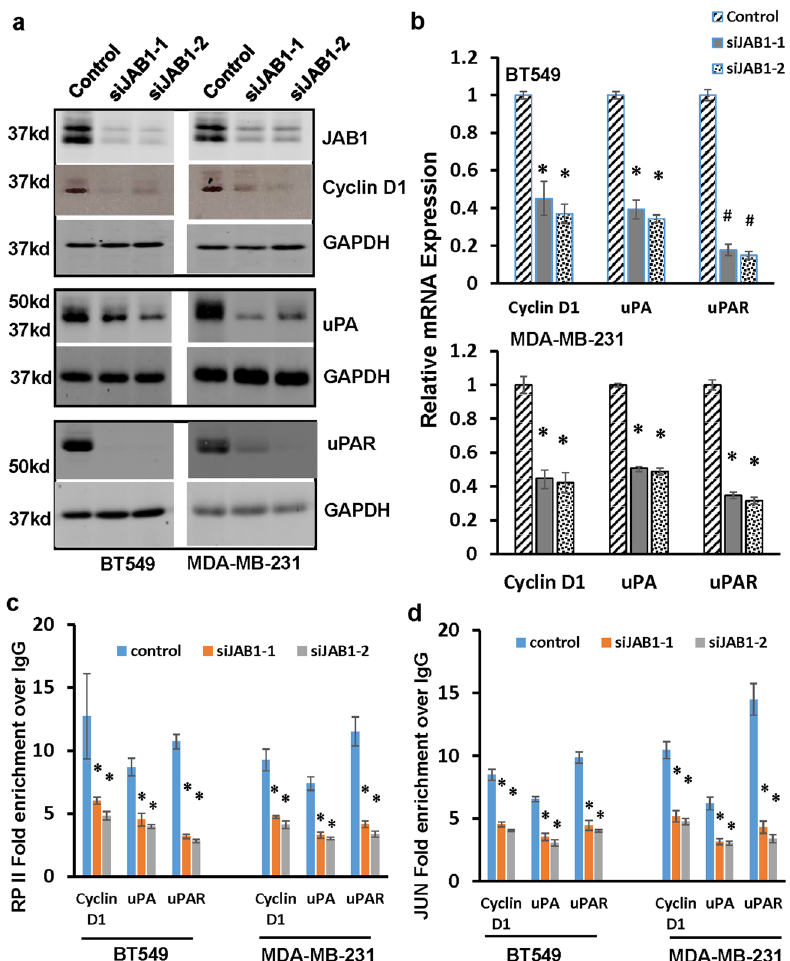
Fig. 5 The presence of JAB1 is required for AP1-driven transcription in TNBC cells. a BT549 or MDA-MB-231 cells were treated with 30 nM JAB1 siRNAs (siJAB1-1, siJAB1-2) or scrambled siRNA control for 3 days followed by western blot analysis to detect JAB1, cyclin D1, uPA, uPAR, and GAPDH with the respective antibodies. Data are the representative of two independent experiments. All blots derived from the same experiment and were processed in parallel. b BT549 or MDA-MB-231 cells were treated with 30 nM JAB1 siRNAs or scrambled siRNA control for 3 days followed by qRT-PCR to measure the levels of Cyclin D1, uPA and uPAR mRNA. Level of β Actin mRNA was used for standardization. Data are means ± SD from three experiments. * P < 0.01 vs Control; # P < 0.005 vs Control. c , d BT549 or MDA-MB-231 cells were treated with 30 nM JAB1 siRNAs or scrambled siRNA control for 3 days and then subjected to RP-II ( c ) or JUN ChIP ( d ) followed by qPCR to analyze RP-II or JUN occupancy in cyclin D1, uPA and uPAR promoters. Data are means ± SD from three experiments. * P < 0.01 vs